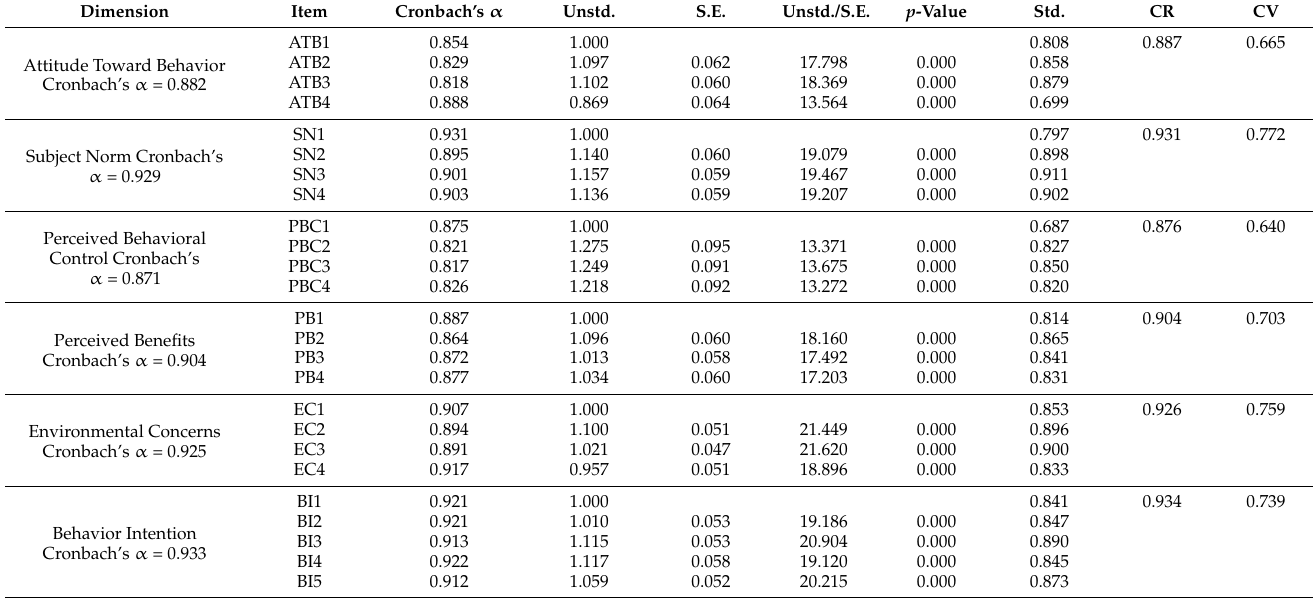
Table 3. Measurement model.